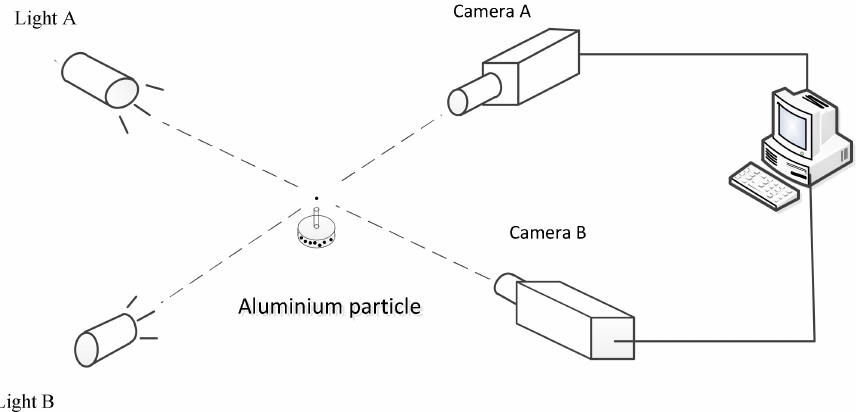
Figure 6. Schematic of calibration